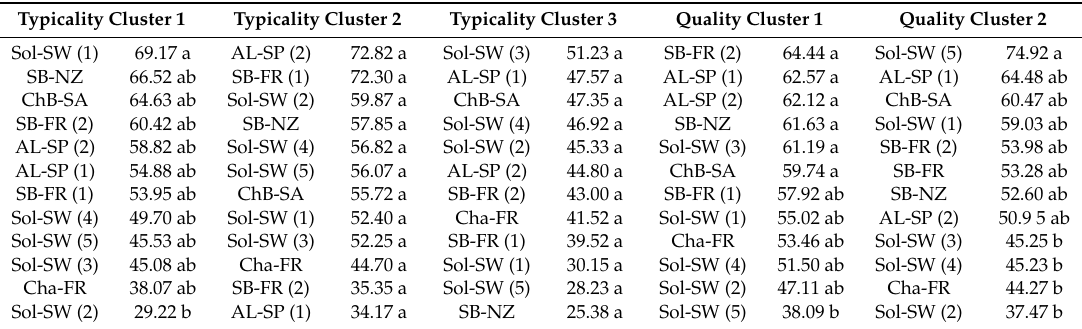
Table 2. Average scores for the typicality and quality clusters. Means within a column with di ff erent letters were significantly di ff erent according to Tukey test (alpha =